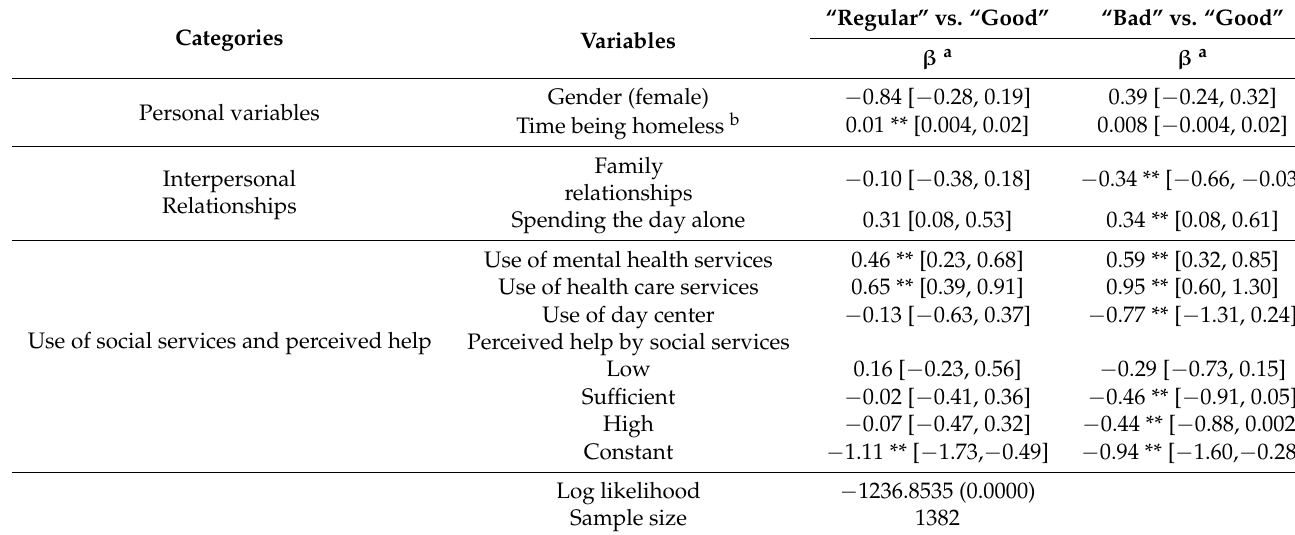
Table A4. Impact of some variables on the self-perceived health status (multinomial probit, good SRH as base